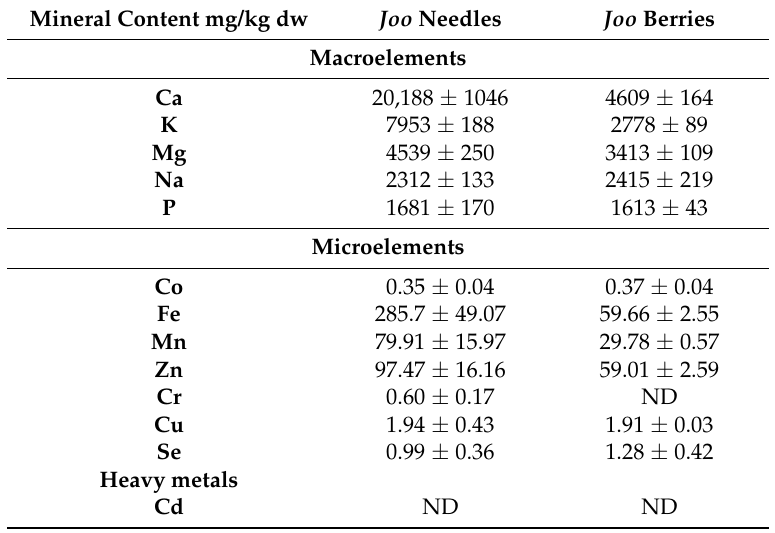
Table 2. The levels of mineral contents in needles and berries of Juniperus oxycedrus subsp. oxycedrus